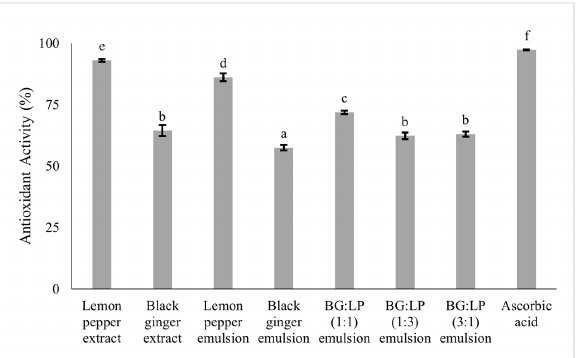
Figure 2. Antioxidant activity of lemon pepper (LP) and black ginger (BG) extracts and macroemul- sions. Note: (a, b, c, d, e, f) letter differences indicate a significant difference between the samples at p < 0.05 according to Duncan method for post hoc test.